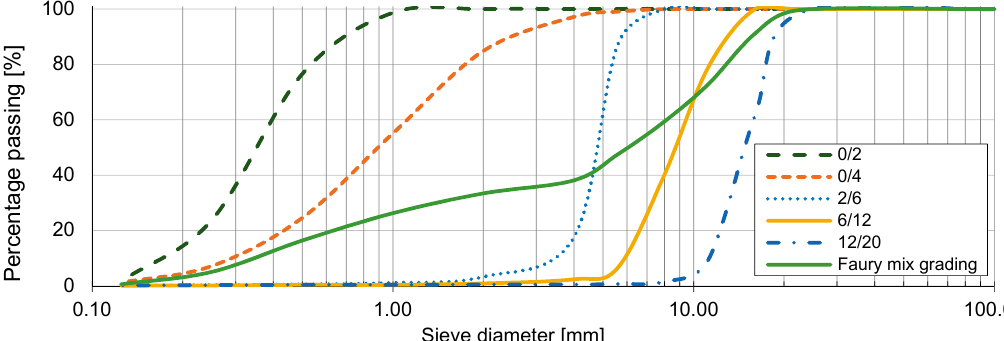
Table 2. Characterization of the aggregates. Material